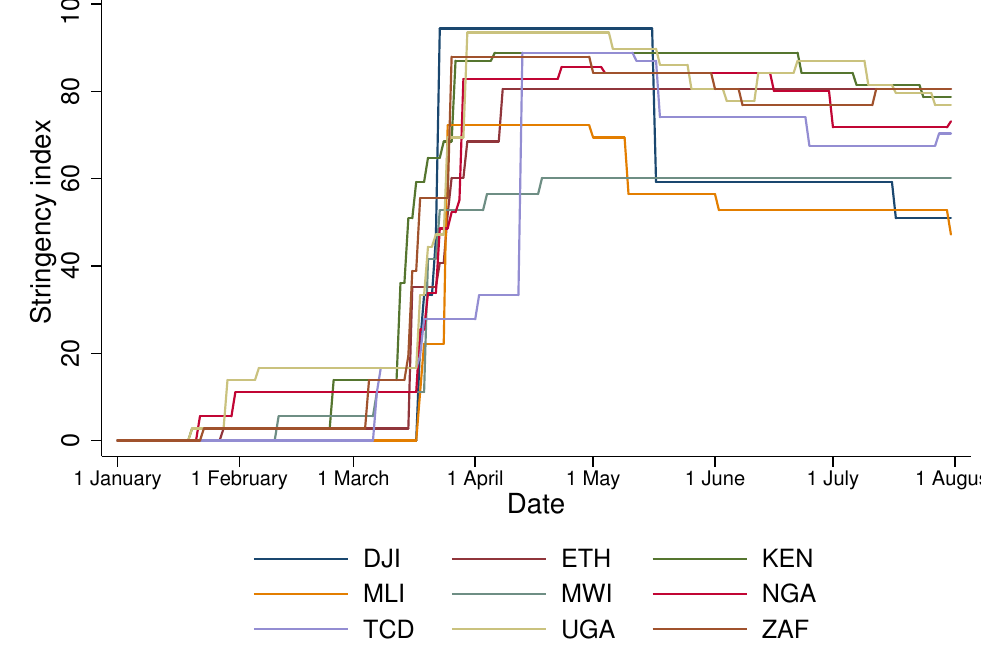
Figure 1. Stringency of government responses according to